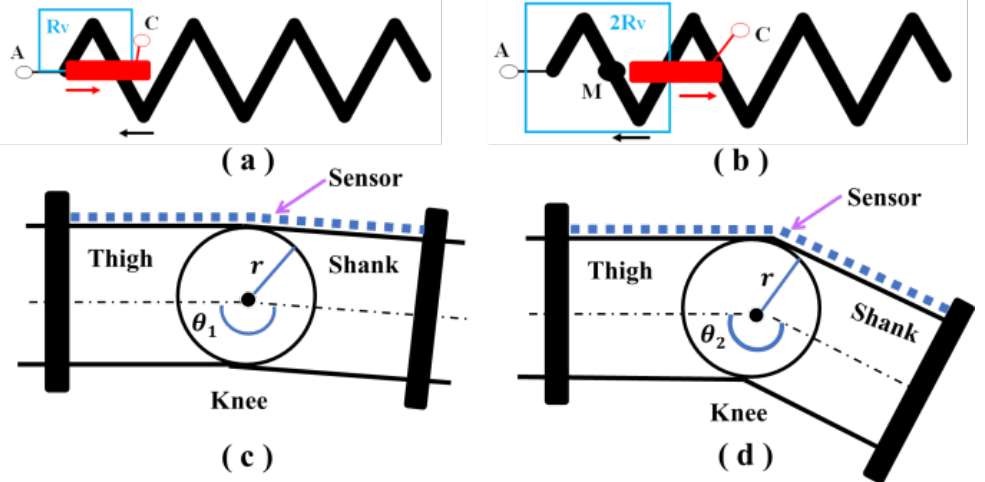
Figure 2. ( a , b ) Schematic diagrams of the working principle of the textile sensor. ( c , d ) The working principle of the sensor for knee movement measurements.